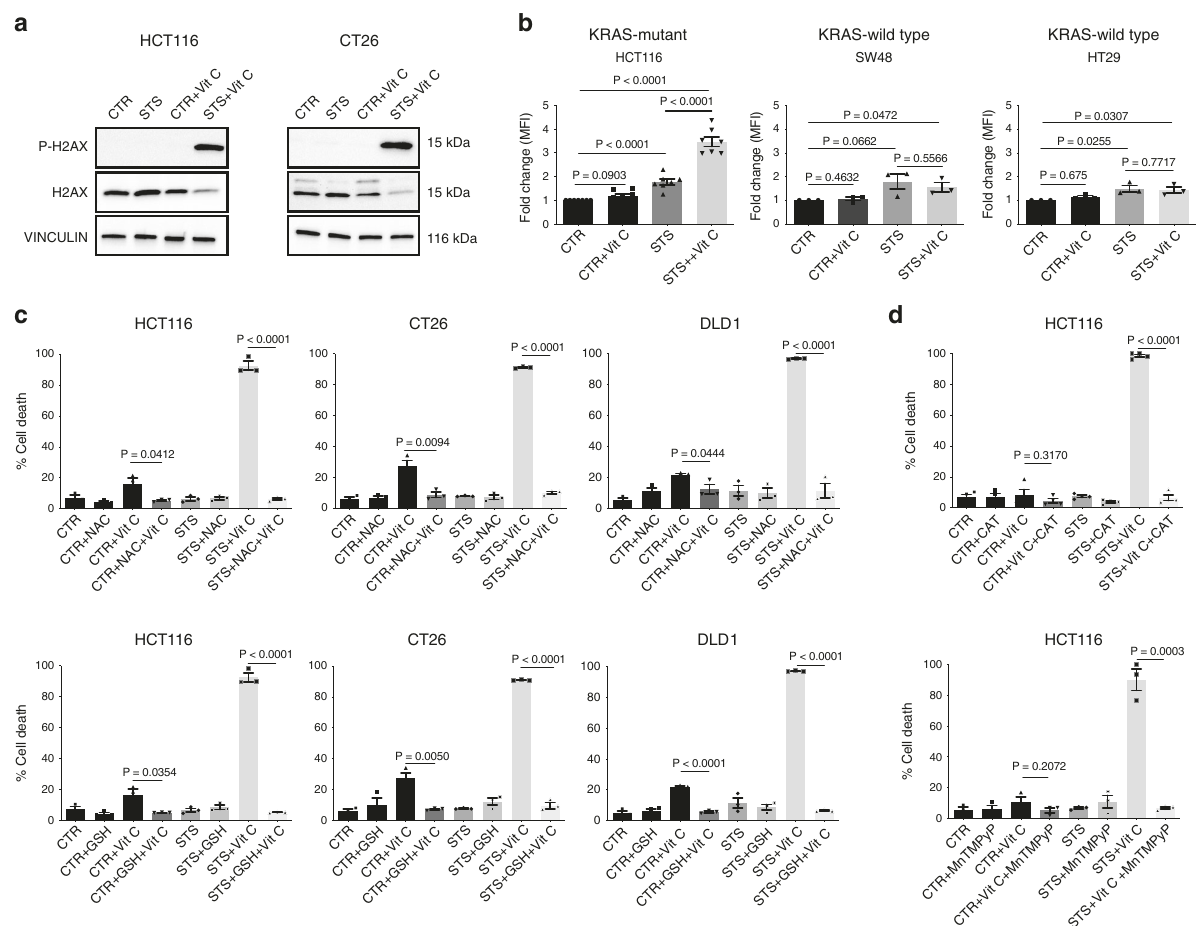
Fig. 2 ROS mediate KRAS -mutant cancer cell sensitization to vitamin C via STS. a Detection of phosphorylated H2AX levels in HCT116 and CT26 by western blotting, total H2AX and VINCULIN as loading control ( n = 3). b CellROX-Deep-Red ROS detection by fl ow cytometry in HCT116 ( n = 7), SW48 and HT29 ( n = 3). MFI: mean fl uorescence intensity. P values were determined by two-sided unpaired t -test. HCT116: exact p value = 0.00000004 (CTR vs STS + Vit C), 0.00003 (CTR vs STS), 0.00001 (STS vs STS + Vit C). c Viability of HCT116 ( n = 3), CT26 ( n = 3), DLD1 ( n = 3) cells treated for 48 h with STS with or without vitamin C, glutathione (GSH), N-acetyl cysteine (NAC) and d catalase (CAT, n = 4) or the superoxide dismutase (SOD)/catalase mimetic MnTMPyP (HCT116, n = 3). P values were determined by two-sided unpaired t -test. HCT116 in ( c ): exact P values = 0.000009 (STS + Vit C vs STS + NAC + Vit C), 0.000007 (STS + Vit C vs STS + GSH + Vit C); CT26: exact P values = 0.00000007 (STS + Vit C vs STS + NAC + Vit C), 0.000002 (STS + Vit C vs STS + GSH + Vit C); DLD1: exact P values = 0.00005 (STS + Vit C vs STS + NAC + Vit C), 0.000000003 (STS + Vit C vs STS + GSH + Vit C), 0.00008 (CTR + Vit C vs CTR + GSH + Vit C). HCT116 in ( d ): exact P value = 0.000000007 (STS + Vit C vs STS + Vit C + CAT). All data are represented as mean ± SEM, n = independent